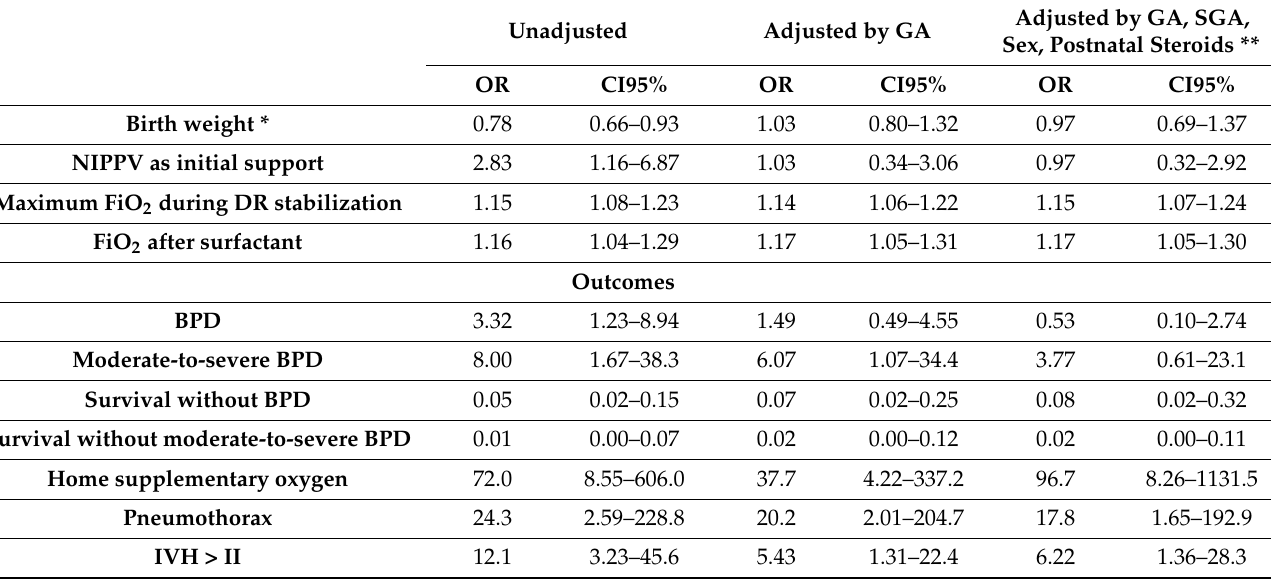
Table 3. Odds ratios and their 95% confidence intervals for selected